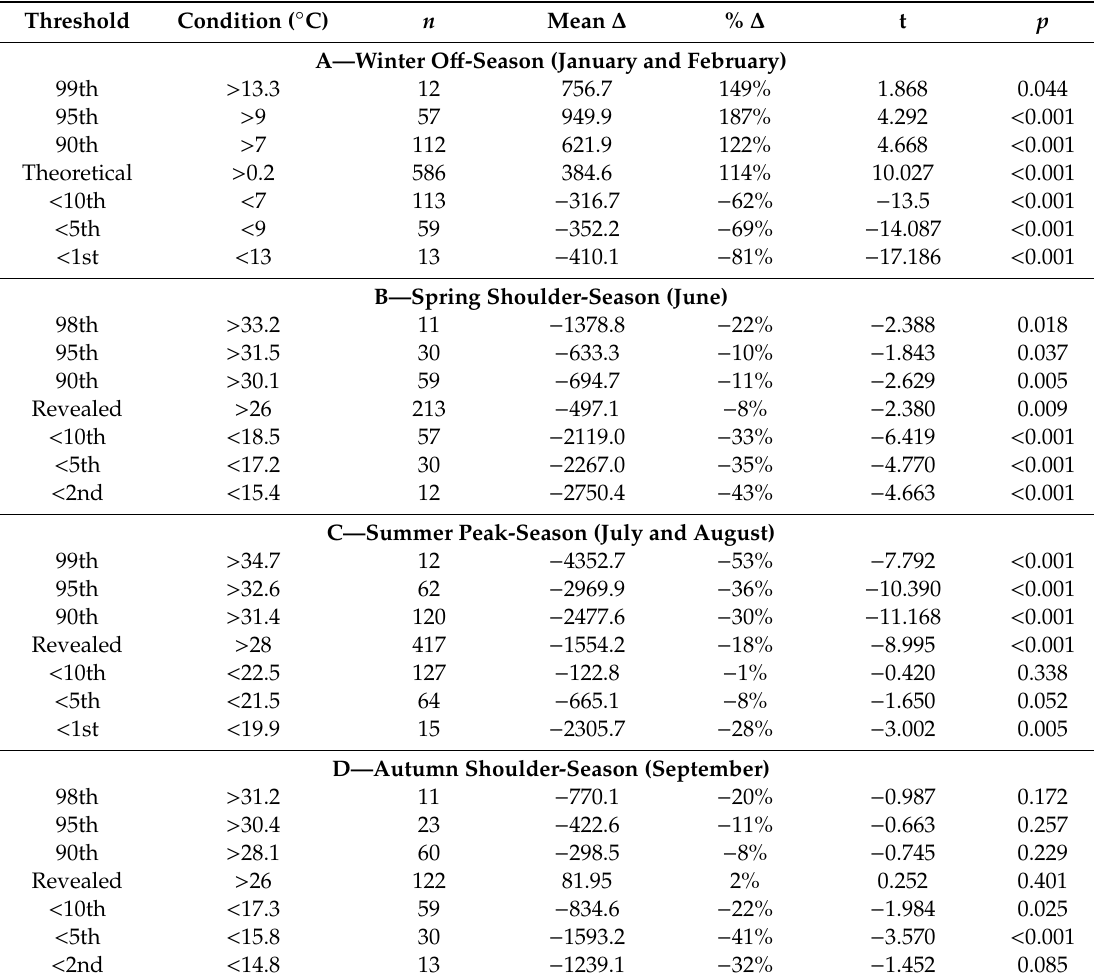
Table 2. The e ff ect of extreme daytime temperatures (daily maximum) on zoo attendance in Toronto, across four di ff erent